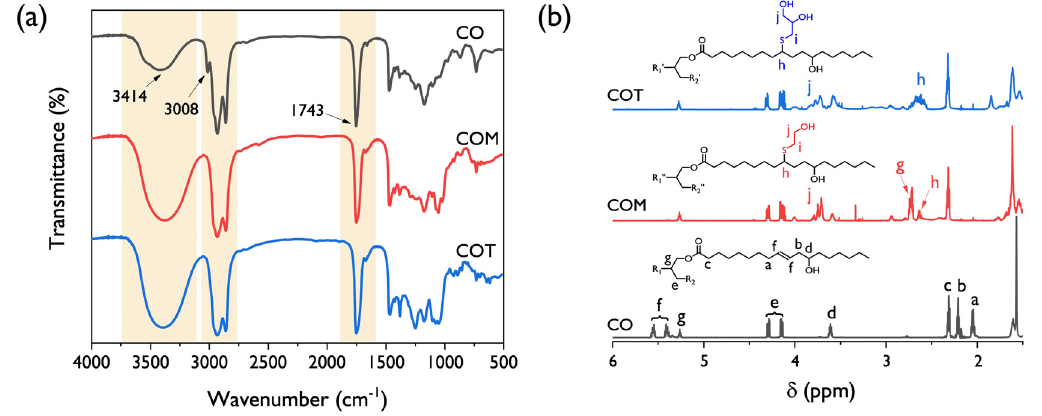
Figure 1. ( a ) FT-IR spectra and ( b ) 1 H-NMR of CO, COM, and COT. The 1 H-NMR spectra of the polyols are shown in Figure 1b. The peaks shown at δ = 4.1–4.4 ppm (peak e) in all the polyols are attributed to –CH 2 –CH–CH– bonds and were used for normalization. After the thiol-ene photo-click reaction, the peaks between δ = 5.3–5.6 (peak f), corresponding to the C=C bonds in castor oil, completely disappeared. In the 1 H-NMR spectra of COM and COT, the newly formed peaks at δ = 2.6 and 2.7–2.8 ppm (peak h and i) correspond to the protons on the methylene adjacent to sulfur. Furthermore, the peaks at δ = 3.6–3.8 ppm (peak j) are related to the methylene next to the primary